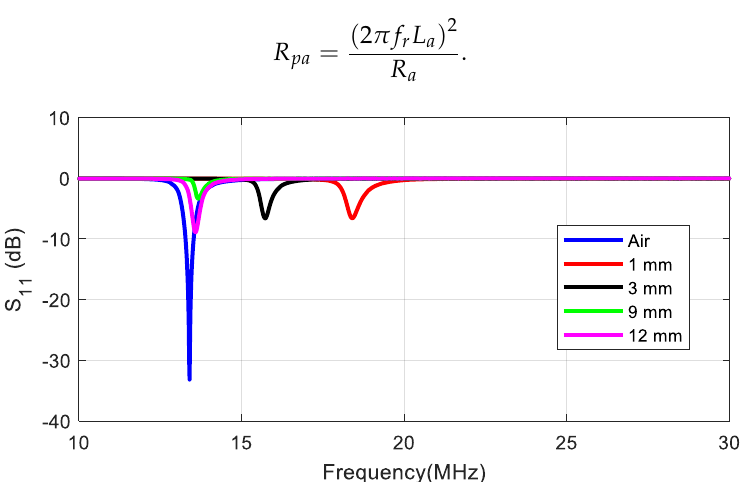
Figure 7. Measured S 11 of the test antenna as a function of frequency for different distances between the tag and the mobile [42].